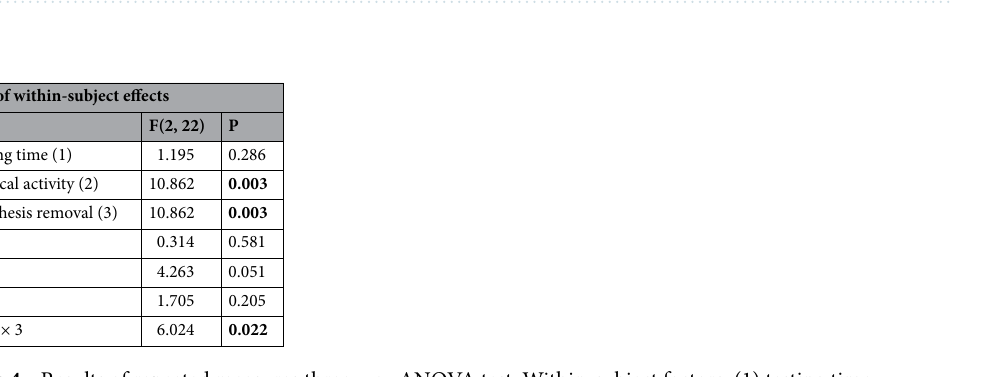
Table 4. Results of repeated measures three-way ANOVA test. Within-subject factors: (1) testing time: morning or afternoon; (2) physical activity: before or after; (3) prosthesis removal: immediately after prosthesis removal or after stabilization